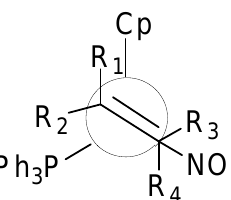
H )Re( η 2 -olefin)-(PPh 5 5 centroid-Re